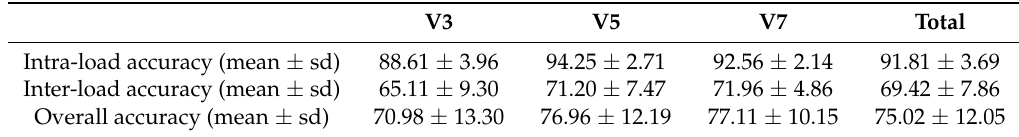
Table 2. Intra-load, inter-load, and overall accuracy of gait recognition (%) (mean ± sd) across